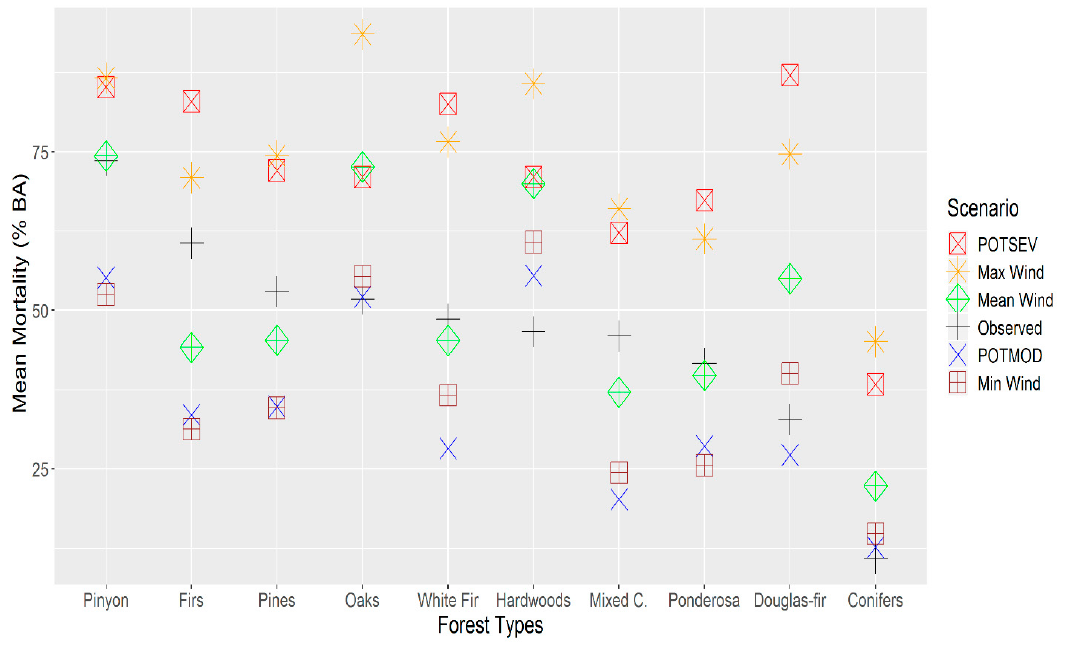
Figure 2. Mean fire-induced mortality as a percent of pre-fire, live tree basal area for modeled weather scenarios and observed by forest type group.